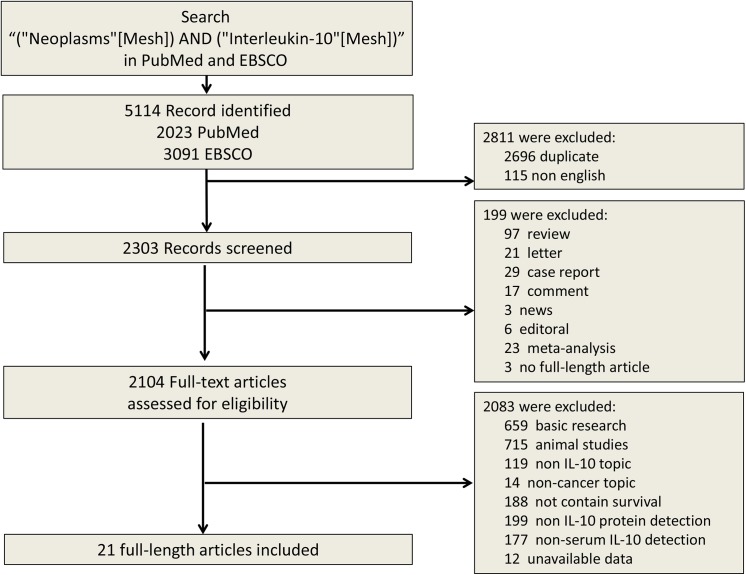
Selection of studies included in the analysis.IL–10 = interleukin–10.